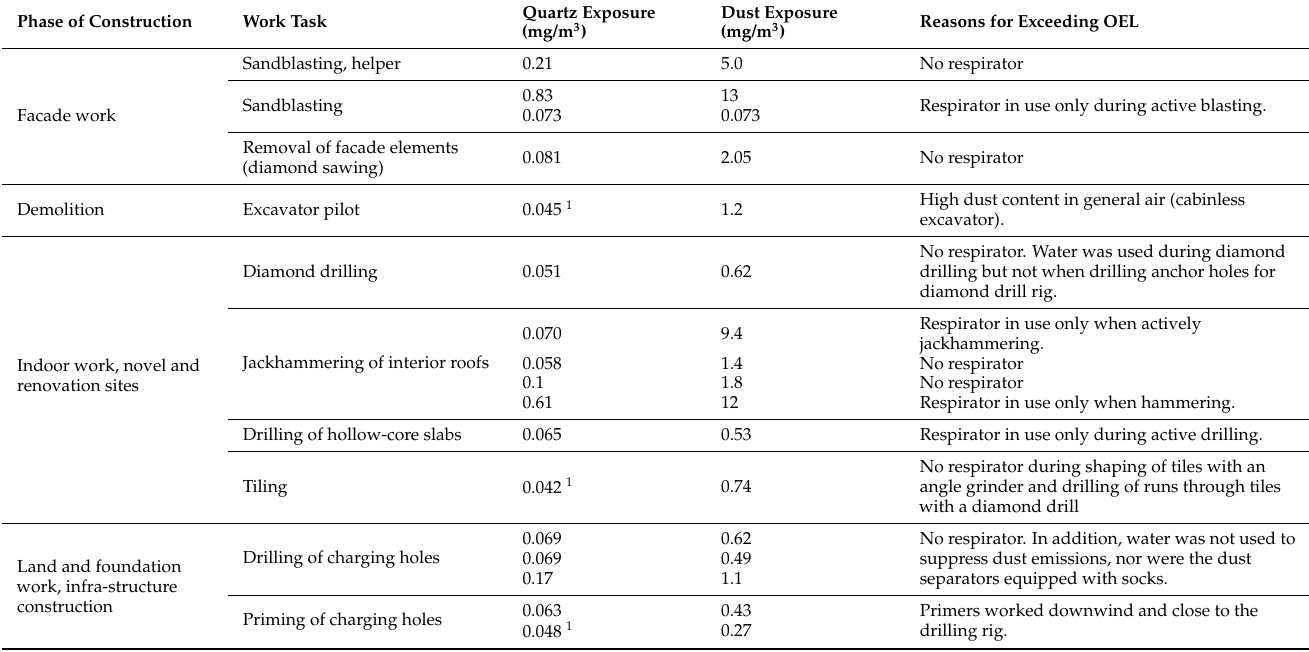
Table 4. Excessive exposures to respirable quartz and dust on investigated construction sites.